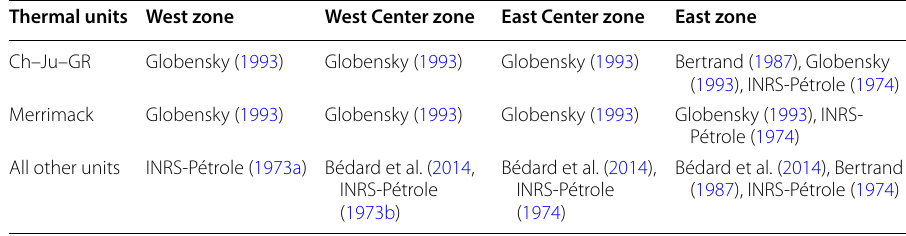
Table 2 Main source of data used to define the synthetic lithological logs by zones Thermal units West